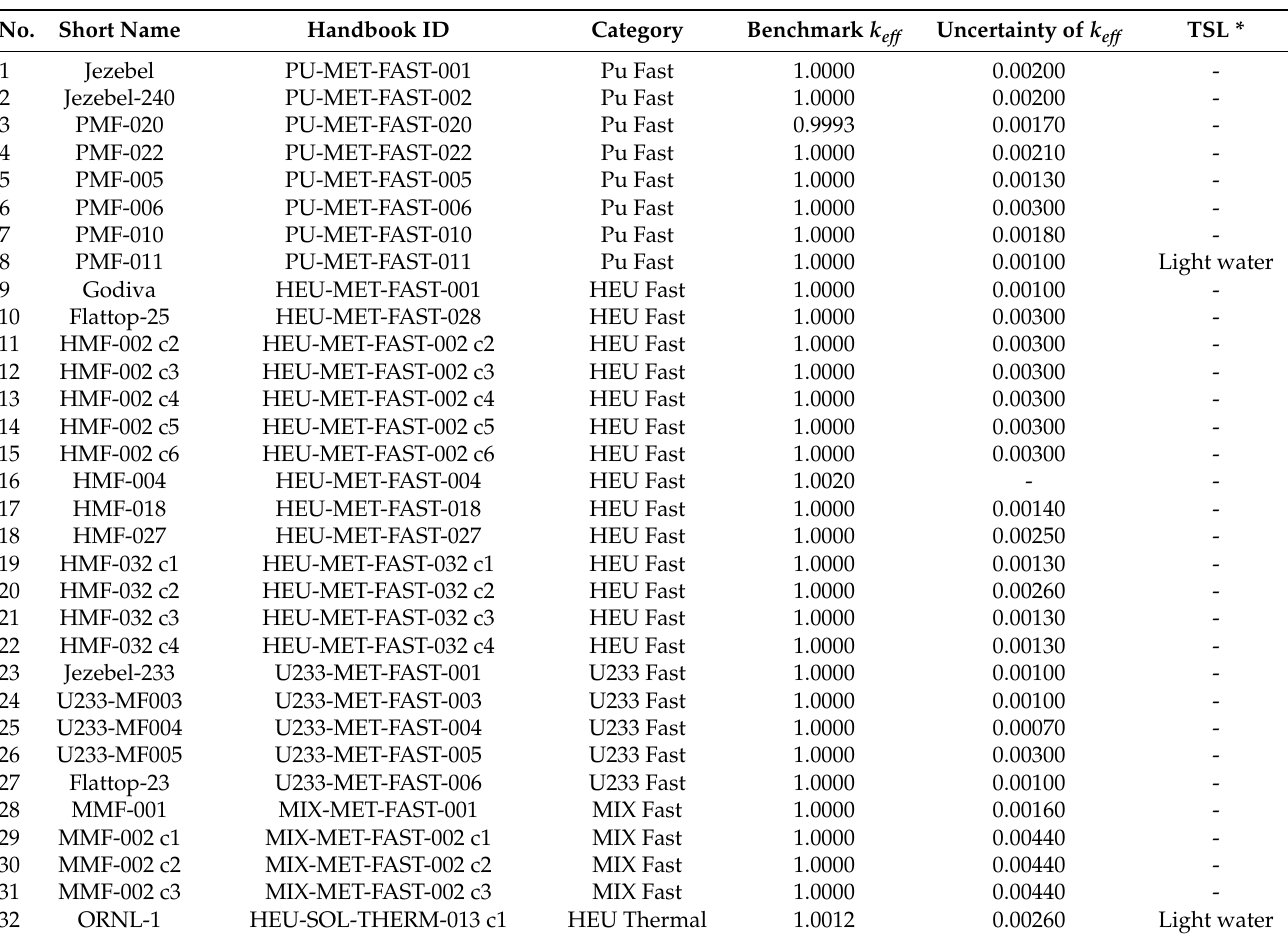
Table 2. A list of selected International Criticality Safety Benchmark